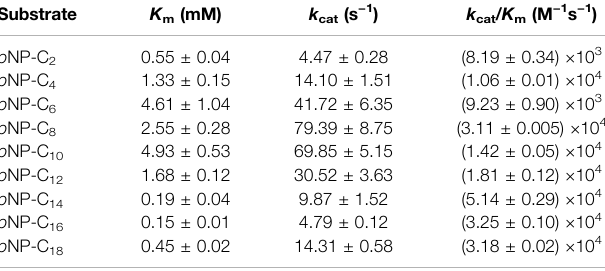
TABLE 1 | MtCut kinetic parameters toward p NP esters a . Substrate